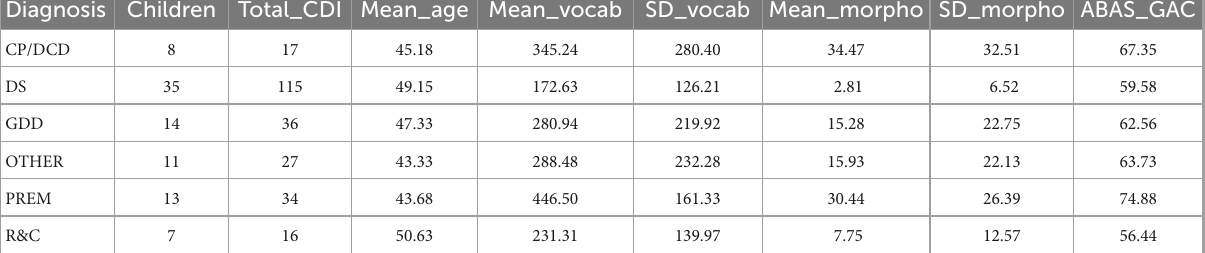
TABLE 1 Participants by diagnosis, including total number of NZCDIs completed per diagnostic category, raw morpho-lexical scores and ABASII